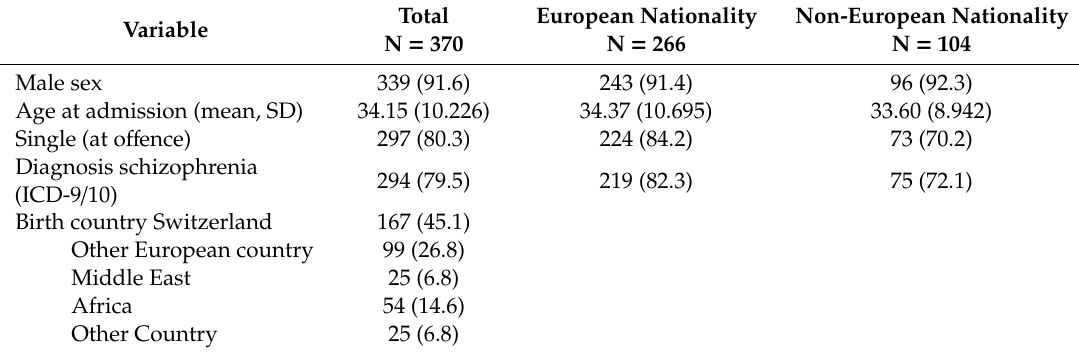
Table 1. Description of study sample.